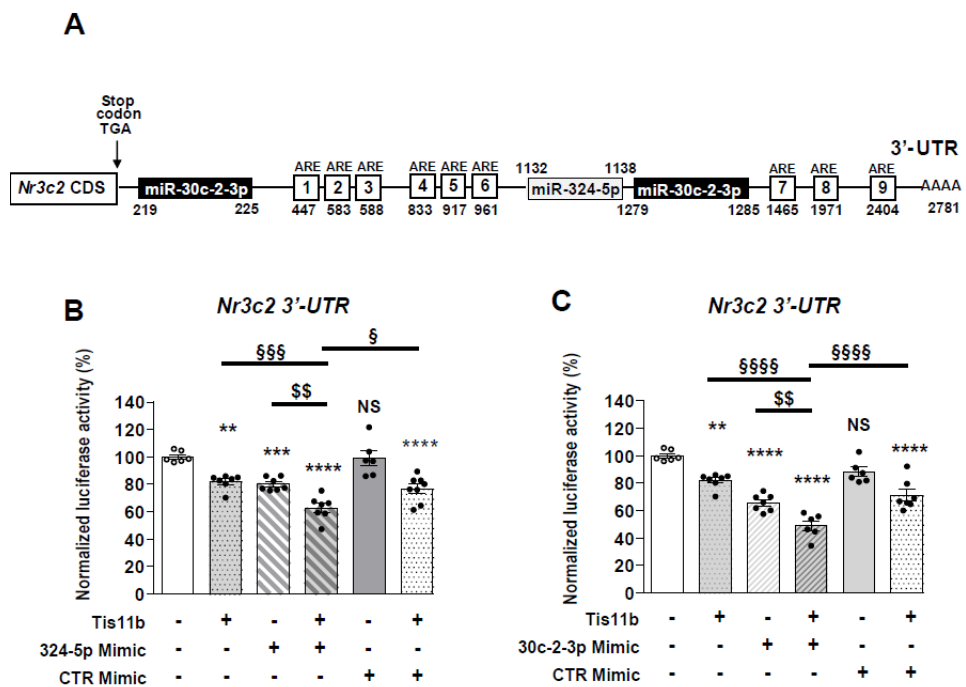
Figure 4. Cooperativity between miR-324-5p or miR-30c-2-3p and Tis11b on Nr3c2 (MR) 3 (cid:48) -UTR. ( A ) Location of A-U rich response elements (ARE) motifs [18] and of putative binding sites for miR-324- 5p and miR-30c-2-3p in mouse Nr3c2 (MR) 3 (cid:48) -UTR, positioned after the stop codon TGA, arbitrarily set at +1. HEK 293T cells were transiently transfected, as described in Materials and Methods Section, with pMIR-luciferase plasmid (pMIR-Luc) fused to Nr3c2 (MR) 3 (cid:48) -UTR (40 ng/well of 96-well plates) with or without a Tis11b-encoding plasmid (10 ng/well) and in the absence or presence of 10 nM Control Mimics (CTR mimic) or of 10 nM 324-5p Mimics ( B ) or 0.5 nM 30c-2-3p Mimics ( C ). Luciferase activities were measured 24 h after transfection and normalized to β -galactosidase activities. Data are means ± SEMs ( n = 8). NS = not significant, ** p < 0.01, *** p < 0.001, **** p < 0.0001 compared to luciferase activity of pMIR-Luc fused to Nr3c2 (MR) without Mimics, Tis11b or with CTR Mimics (CTR Mimic), arbitrarily set at 100%. § p < 0.05, §§ p < 0.01, §§§ p < 0.001 and §§§§ p < 0.0001 between the two conditions indicated by